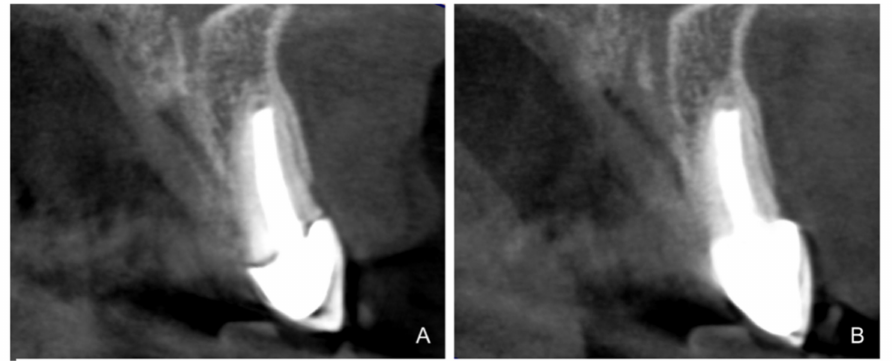
Figure 13. Example before and after re-treatment. ( A ) Initial radiograph of a patient included in the sample with a full-coverage restoration (horizontal line). ( B ) Case after retreatment with a prosthetic zirconia crown, using the BOPT technique. Note the difference in the marginal fit between the two types of dental